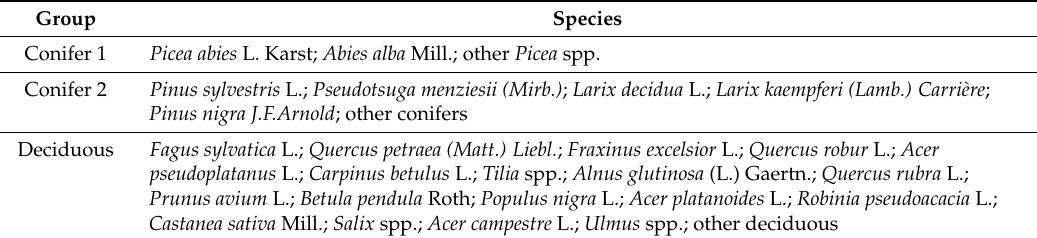
Table A3. Species included in the plot type attribute characteristics. Only species with more than 30 individuals in the training set are named explicitly. The species (groups) were ranked according to their frequency in the training set.